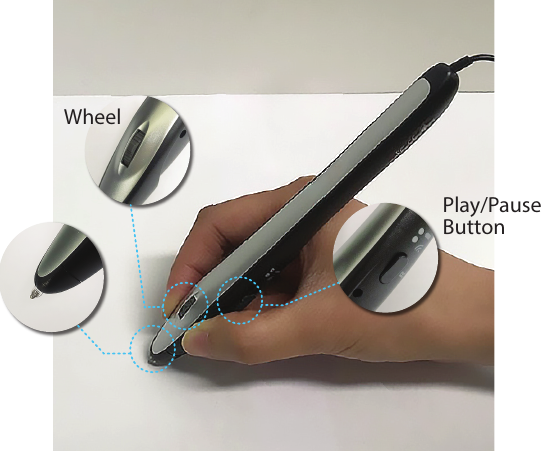
Figure 2. HearIt